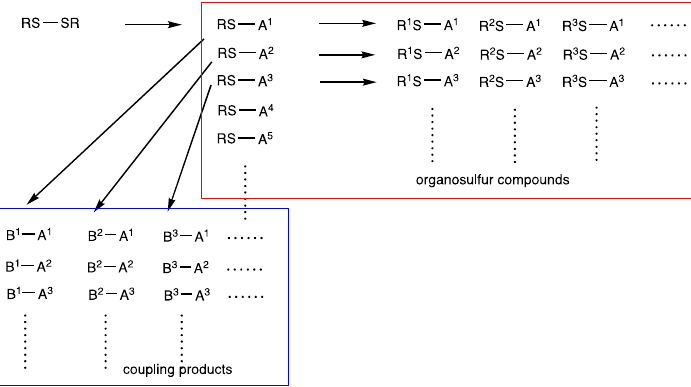
Figure 8. Synthesis of diverse organosulfur compounds and coupling products by rhodium-catalyzed reactions of disulfides.